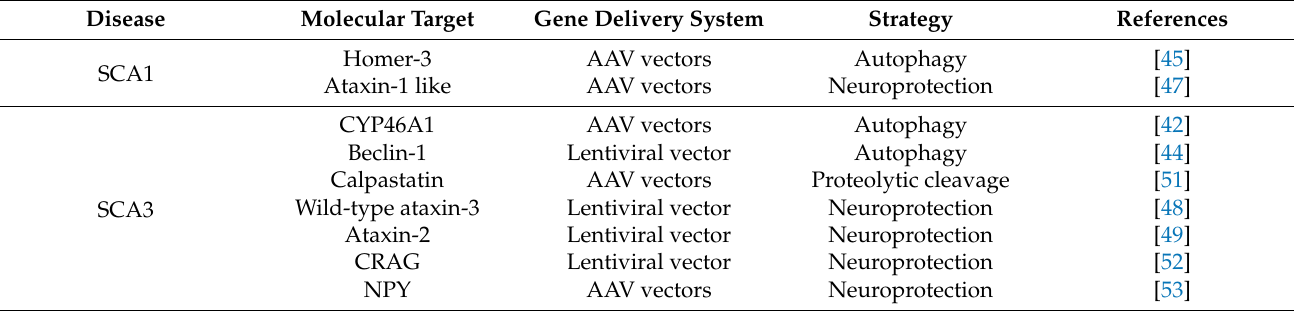
Table 3. Selected gene augmentation strategies studies in polyglutamine spinocerebellar ataxias.